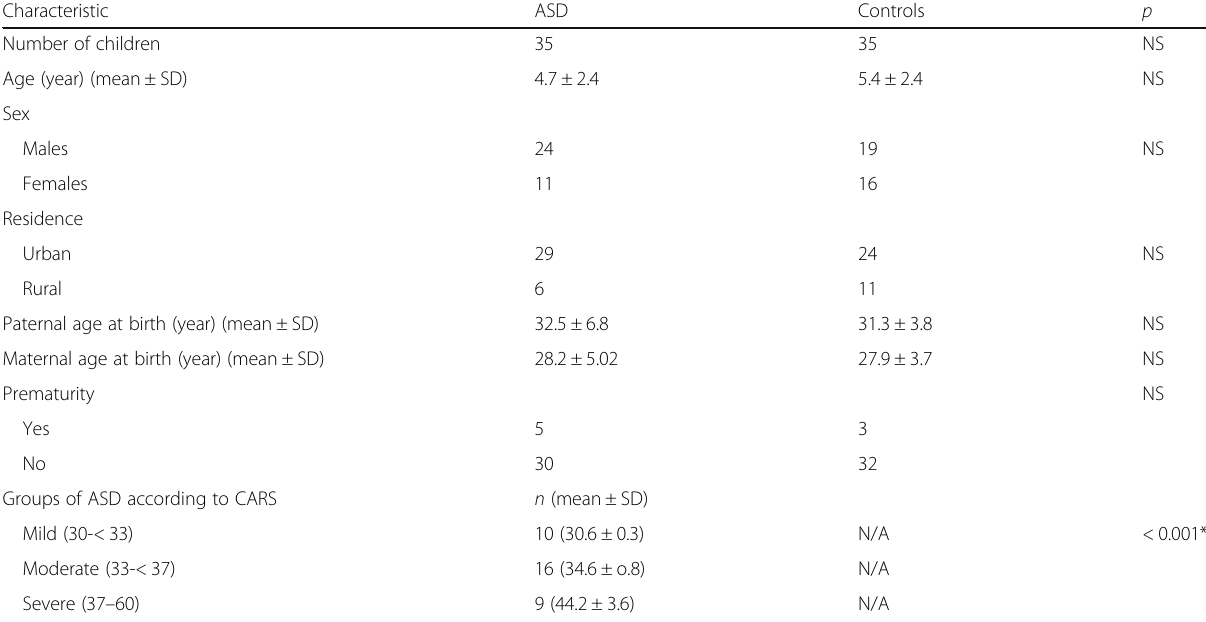
Table 1 Demographic and clinical characteristics data of autism spectrum disorders (ASD) and control children